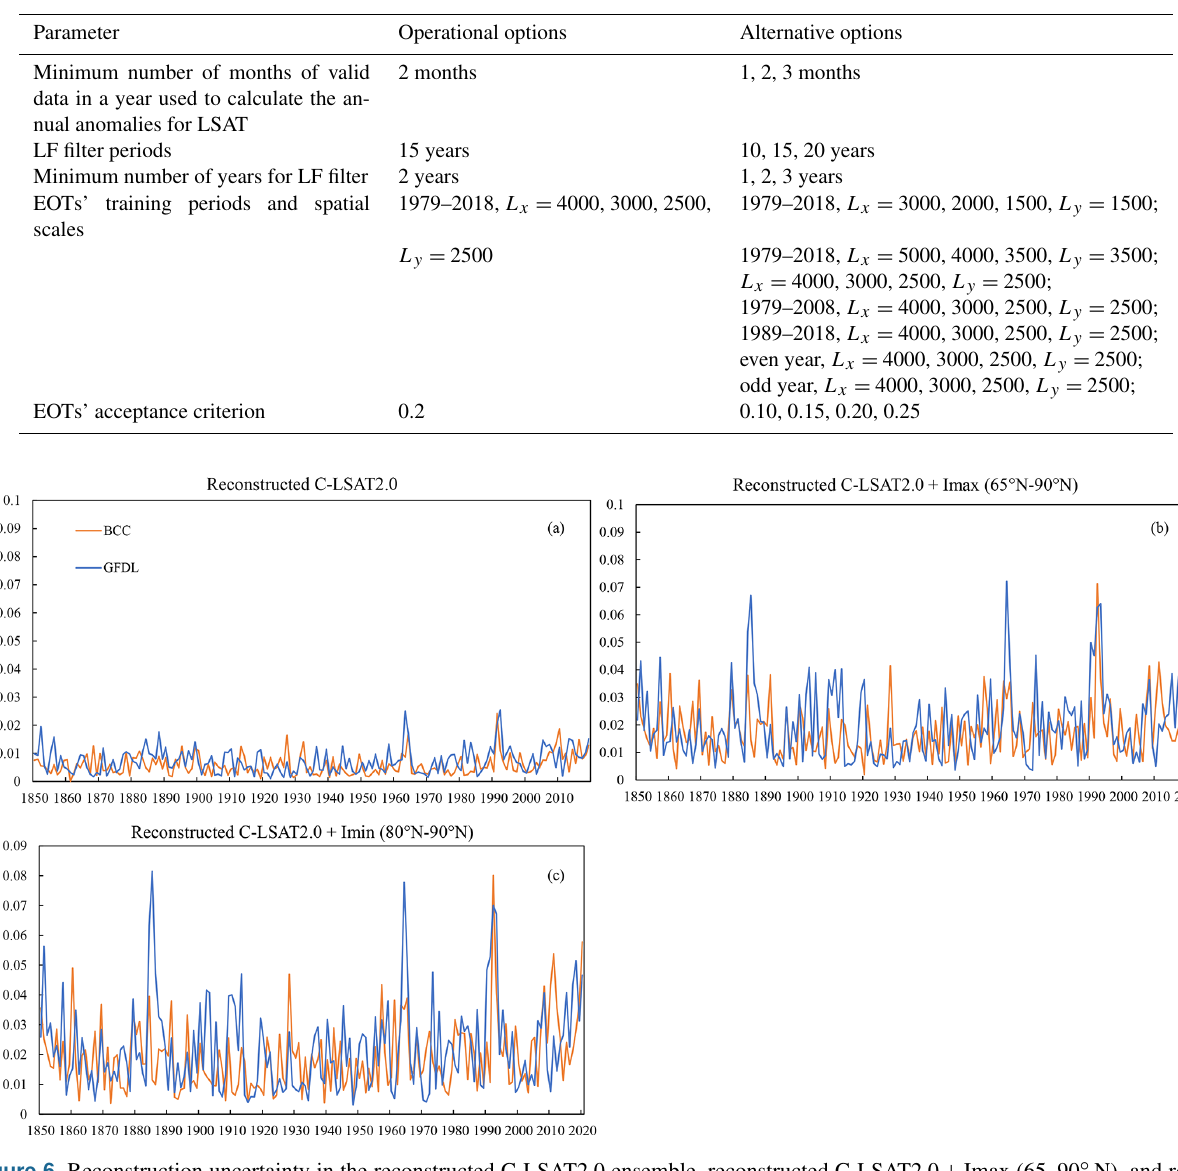
in reconstructed C-LSAT2.0 − Imax and C-LSAT2.0 −